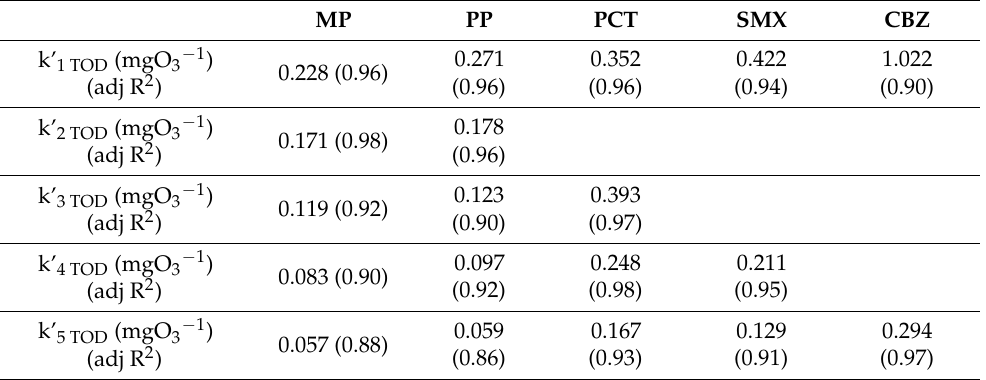
Table 5. Pseudo-first order kinetic rate constant of ozone-treated contaminants, in mixture as function of TOD values. k’ 1 TOD refers to the PPCP individually, whereas k’ 2 TOD , k’ 3 TOD , k’ 4 TOD , and k’5 TOD , refer to Mix.2, Mix.3, Mix.4, and Mix.5, respectively. The corresponding adjusted coefficients of determination (adj R 2 ) are also presented.